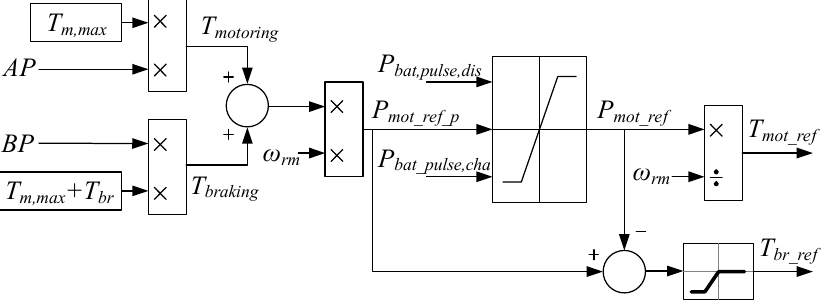
Figure 1. Block diagram for the generation of traction and braking torque reference of an electric vehicle.